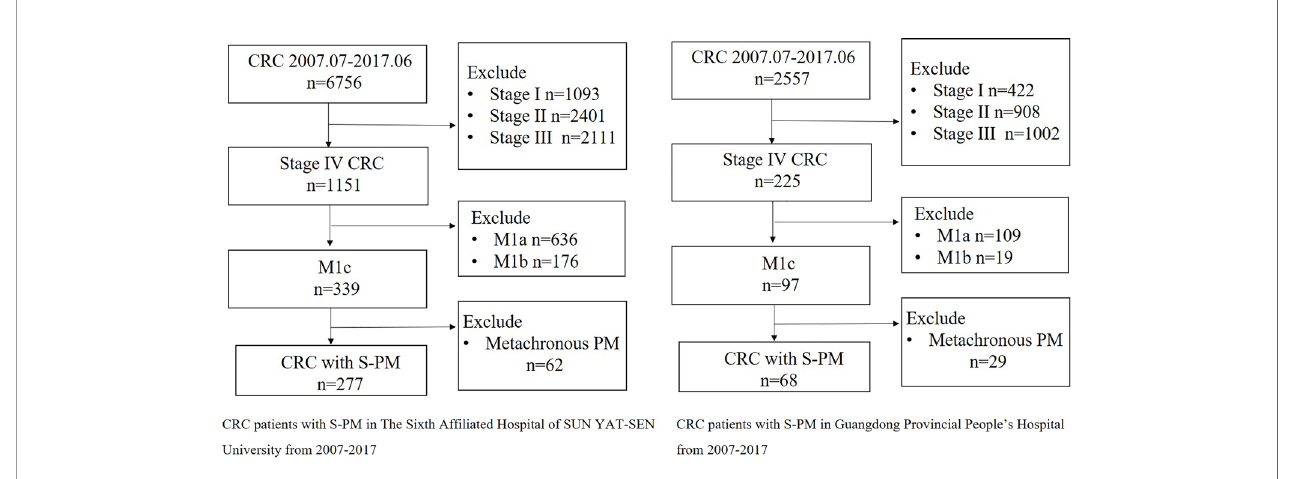
FIGURE 1 | Flow chart of patient selection in two medical